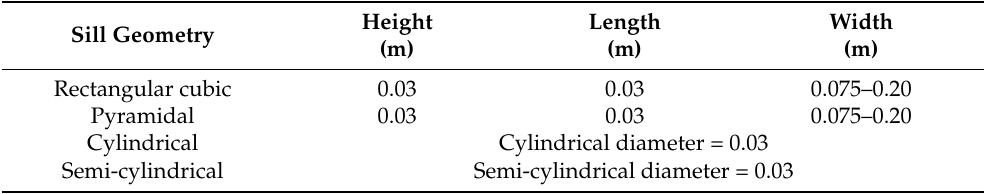
Table 1. Physical characteristics of the sills used in this